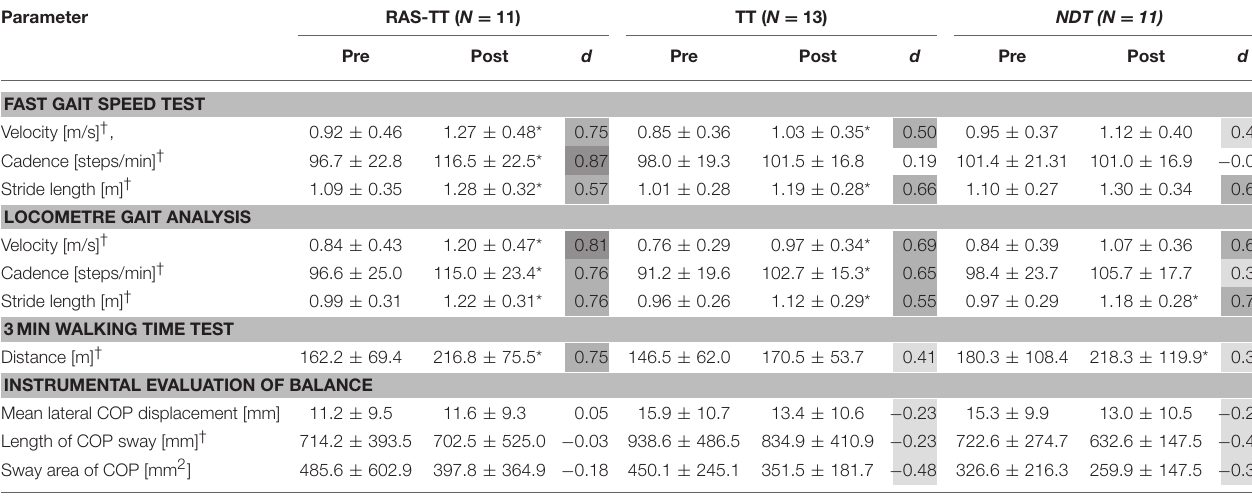
TABLE 2 | Pre and post-intervention measures and effect sizes for gait and postural balance parameters (means ± standard deviation with 95% confidence interval). Parameter